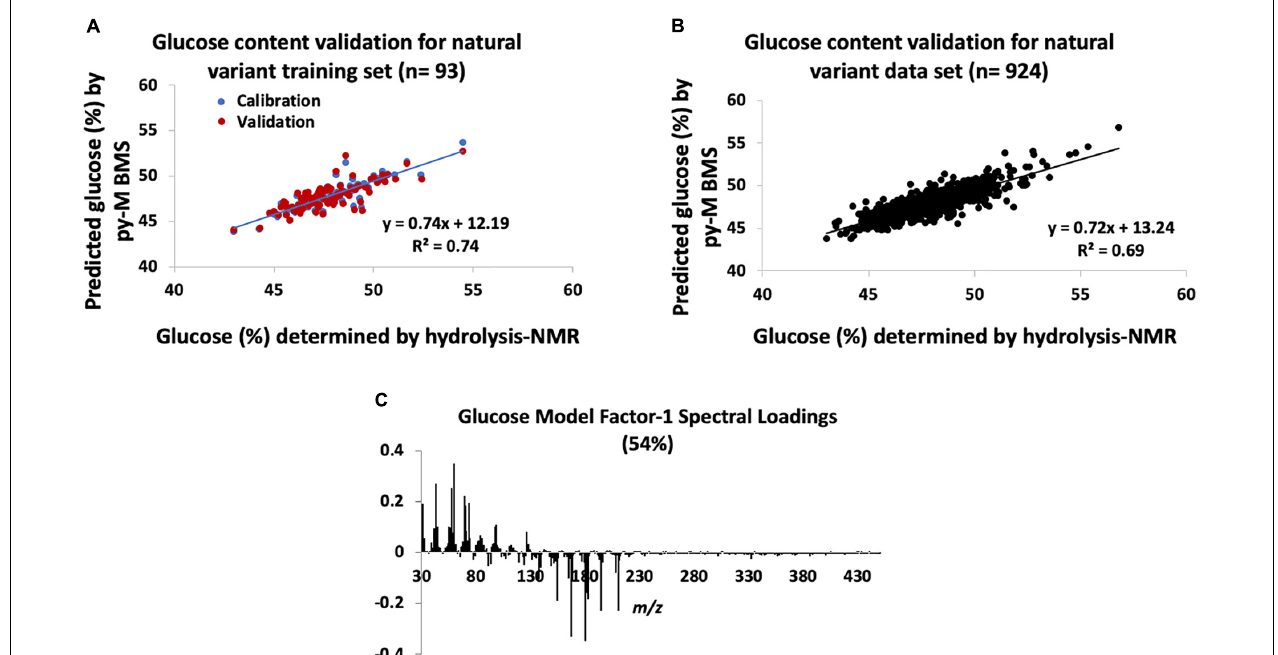
FIGURE 1 | Natural variant glucose models constructed from hydrolysis-nuclear magnetic resonance (NMR) and pyrolysis-molecular beam mass spectrometry (py-MBMS) spectra and validation. (A) Glucose content validation for natural variant training set, (B) glucose content validation for all natural variants tested, and (C) factor-1 spectral loadings for natural variant glucose